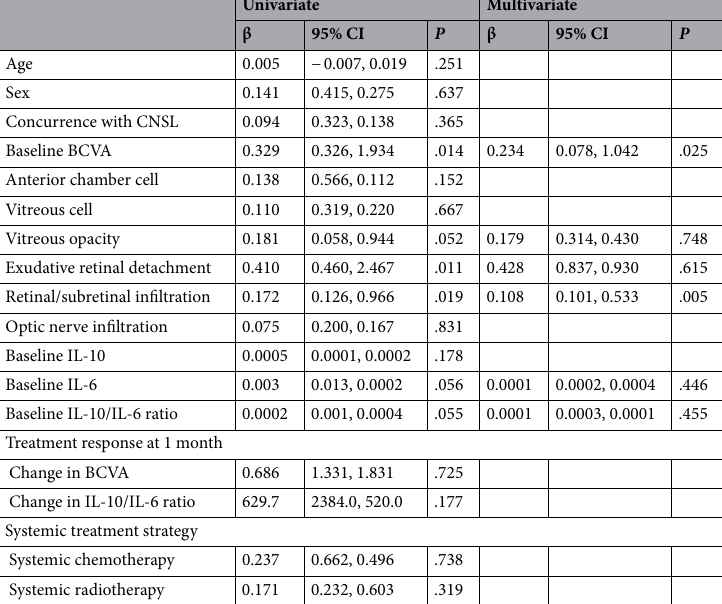
Table 5. Univariate and multivariate linear regression analyses to evaluate the predictors of significant vision loss in eyes with vitreoretinal lymphoma following treatment. BCVA best-corrected visual acuity, CNSL CNS